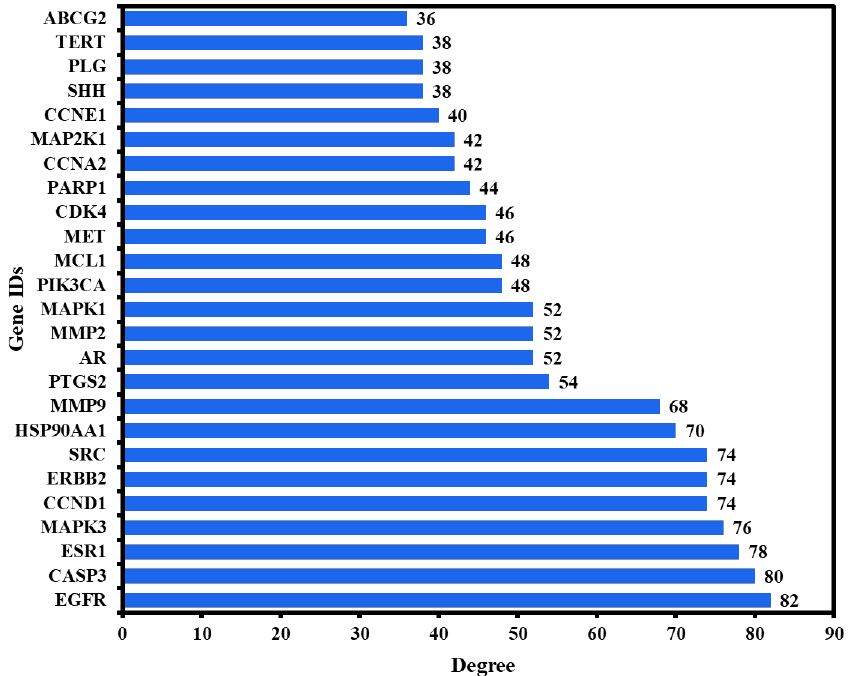
Figure 4. The PPI network’s 25 potential anti-HCC core targets ranked by DC ≥ average value of 32.49.